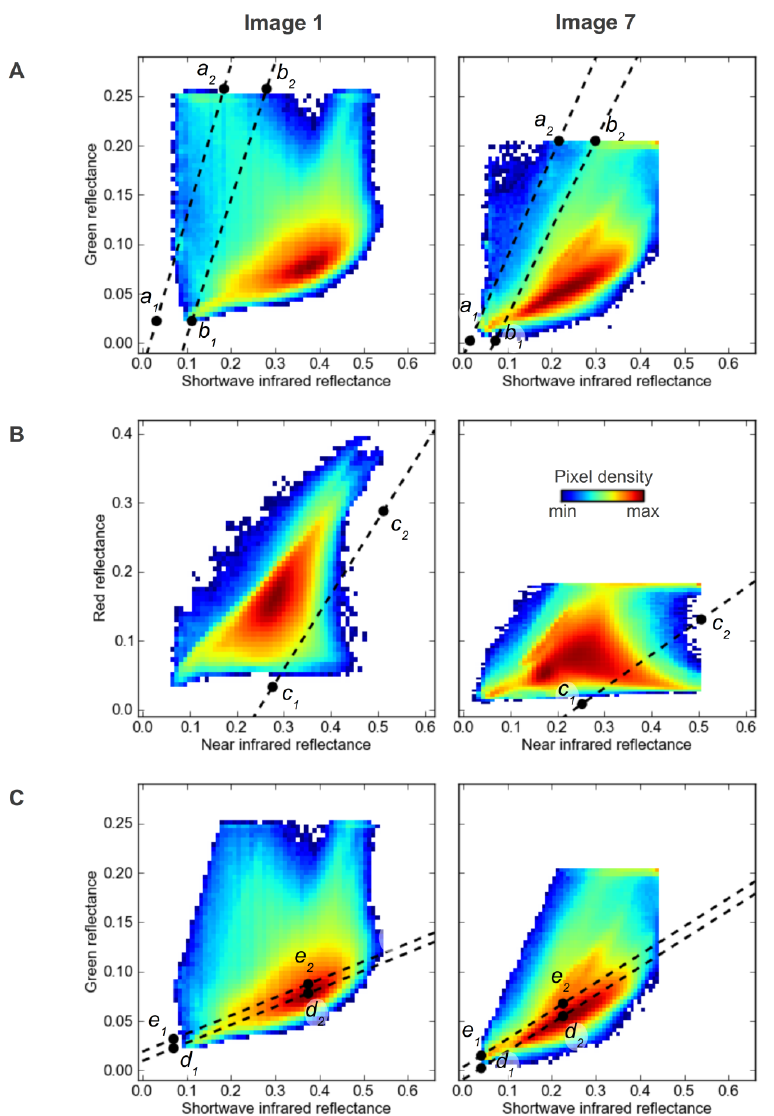
Figure 7. Examples of thresholds identified in image 1 ( Left ) and image 7 ( Right ). Image numbers are from Figure 1 and subsets of these images are shown in the results section. ( A ) Threshold lines for the water mask; ( B ) Threshold lines for the vegetation mask; ( C ) Threshold lines for the cloud